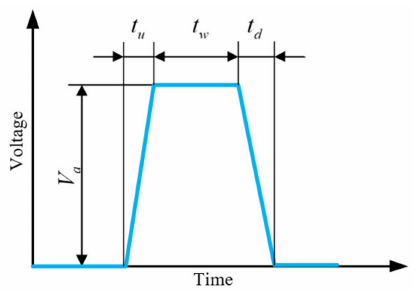
Figure 6. Standard single trapezoidal pulse waveform.